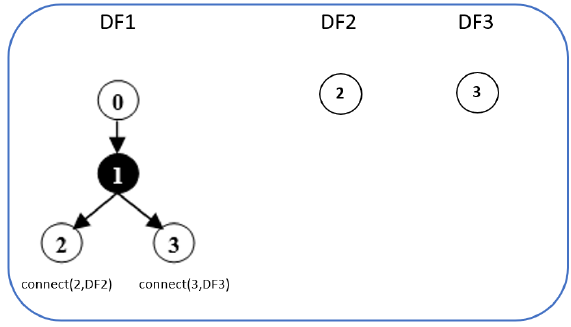
Figure 7. Connect verb.